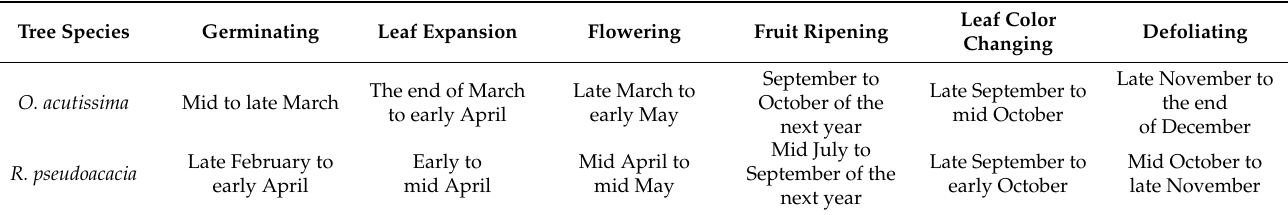
Table 1. Key phenological period of O. acutissima and R. pseudoacacia throughout a year. Tree Species Fruit Ripening